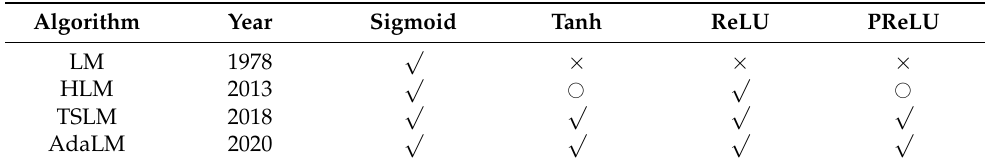
Table 2. Performance comparison of different activation functions.